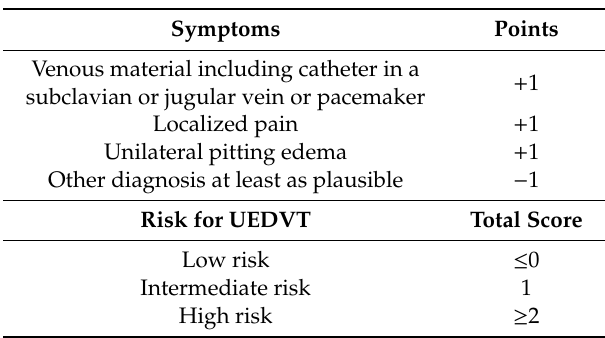
Table 1. Constans